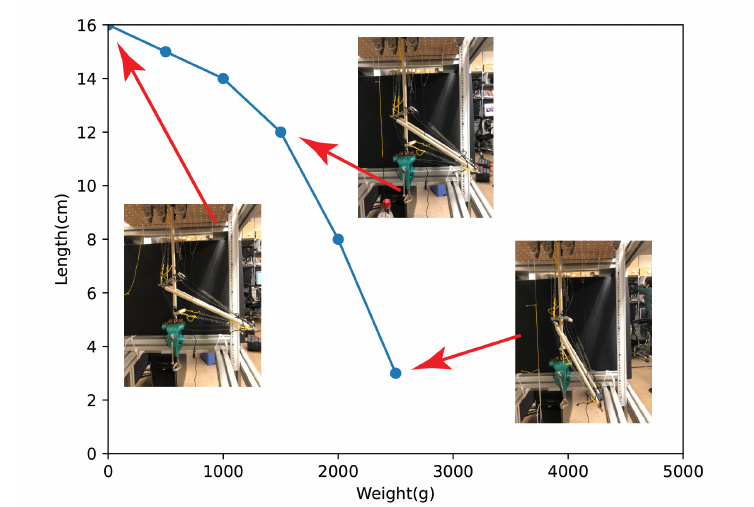
Figure 18. Graph of the height of the tip of the lower arm when it is pulled downward by weights. The embedded images show the states corresponding to the weights.The height of the tip with no weight is 16cm from the base of the device. For weights over 3000 g, measurements were stopped because the compression materials came into contact with each other, and the shape of the arm began to distort.